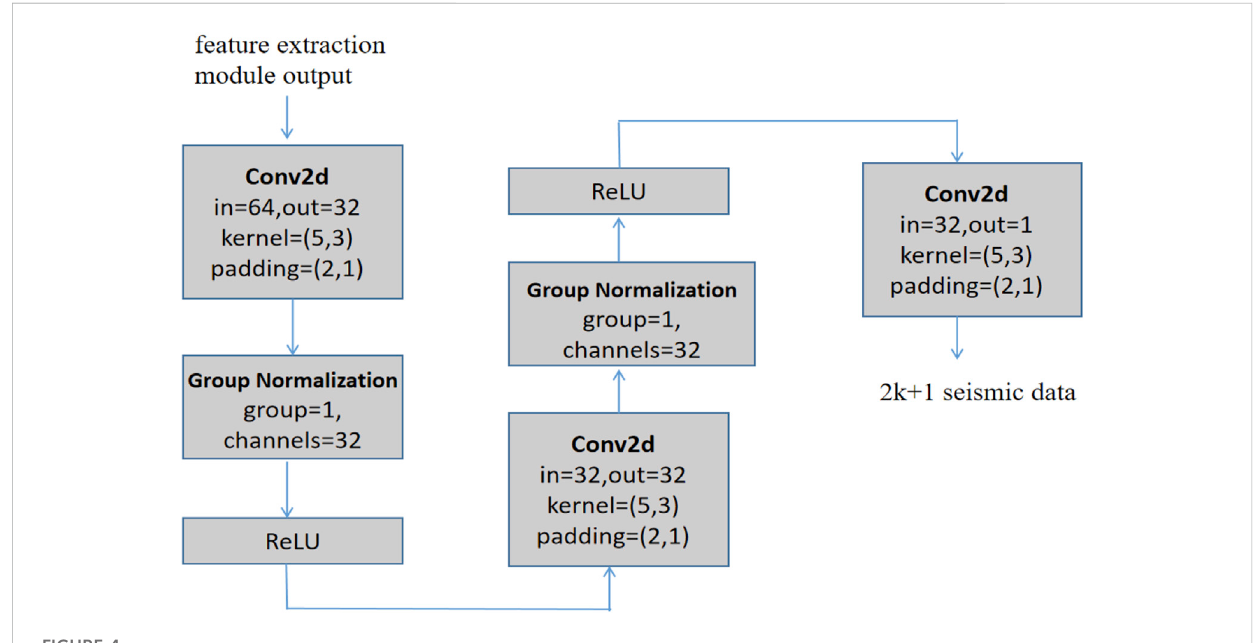
FIGURE 4 Block diagram of the forward